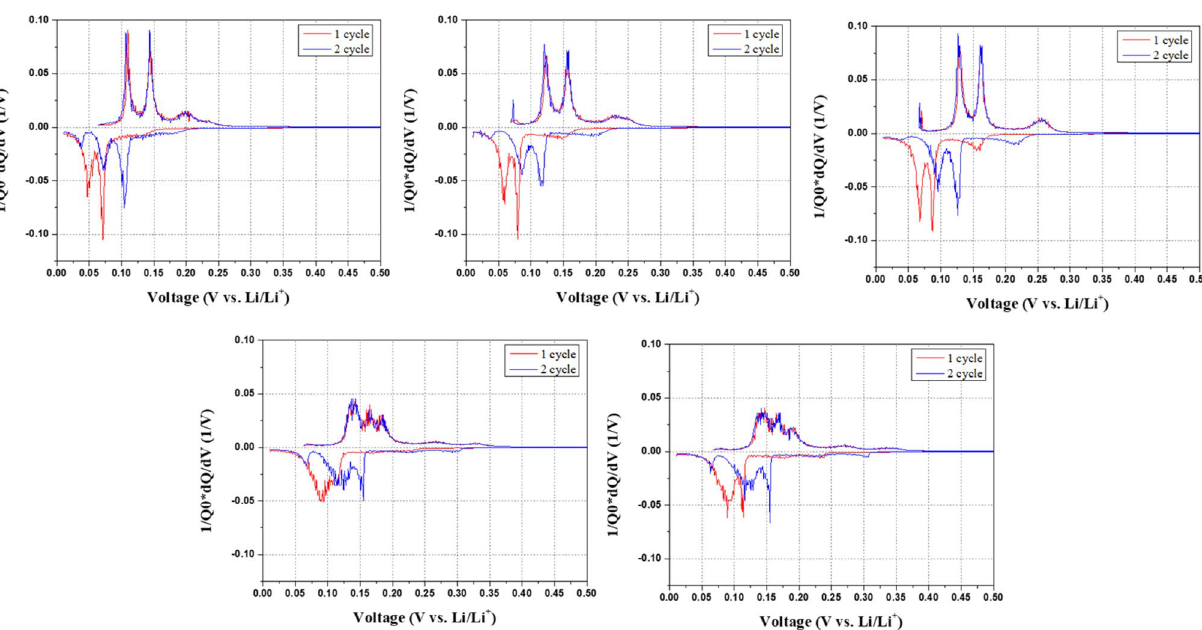
Fig. 11 Differential of first and second cycle profiles. a 4203-B0-2500, b 4203-B1-2500, c 4203-B3-2500, d 4203-B5-2500, e